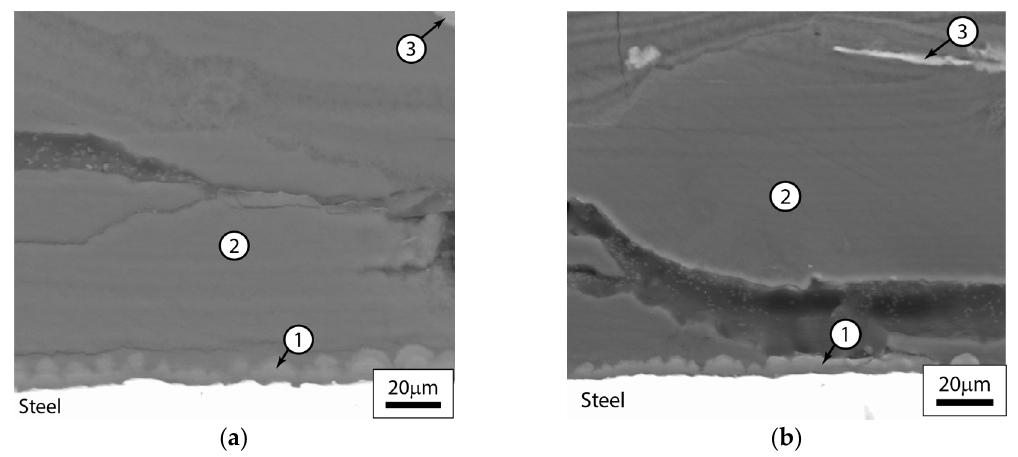
Figure 7. Micrographs of cross-sections of uncoated ( a ) X80 and ( b ) AISI 4137 samples, showing morphology of the deposits after 30 days under ECP of − 1.1 V (Ag/AgCl/saturated KCl).